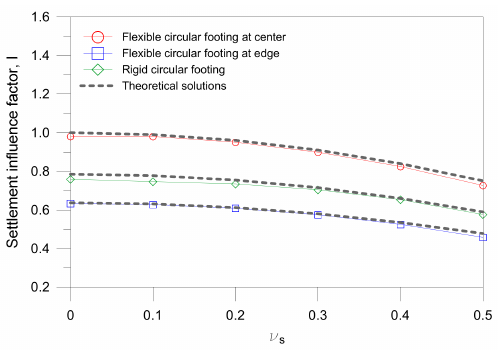
Figure 3. Comparison of FEA results and theoretical